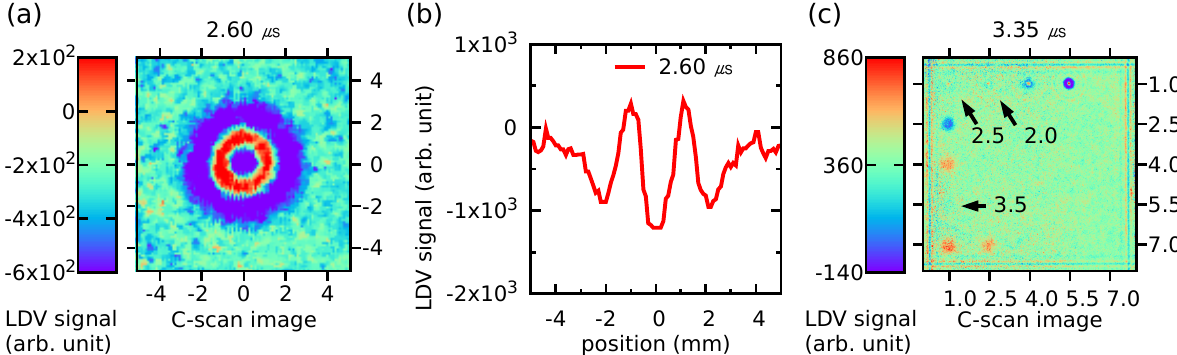
Figure 6. LDV signals of the AL6061 specimen in Band4: ( a , b ) LDV signals of Defect-1.0 of the AL6061 specimen at 2.60 µ s, and ( c ) disappearance of artificial defects such as Defect-2.0, -2.5, and -3.5 of the AL6061 specimen in Band4 when the measuring time is 3.35 µ